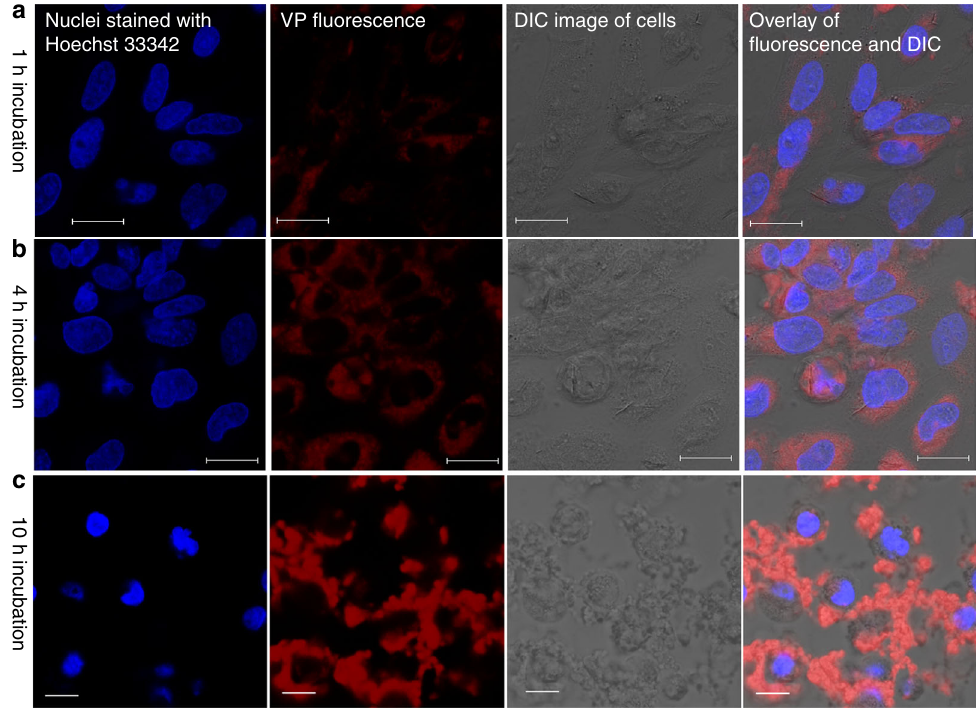
Fig. 3 Cellular uptake activity of liposomes in rat PC12 cells. a – c Representative confocal laser scanning microscopy images of PC12 cells incubated with liposome nanoparticles (25 µ M) for 1, 4 and 10 h, respectively. Scale bar is 20 µ